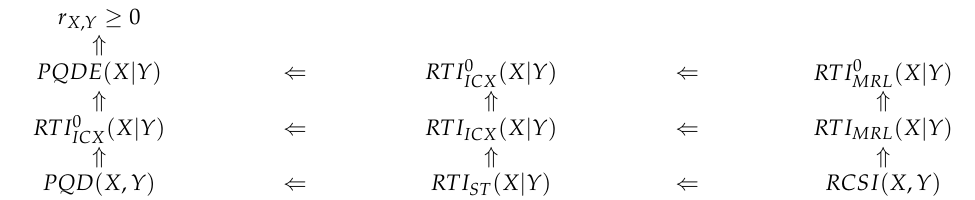
Table 5. Relationships among weak positive dependence